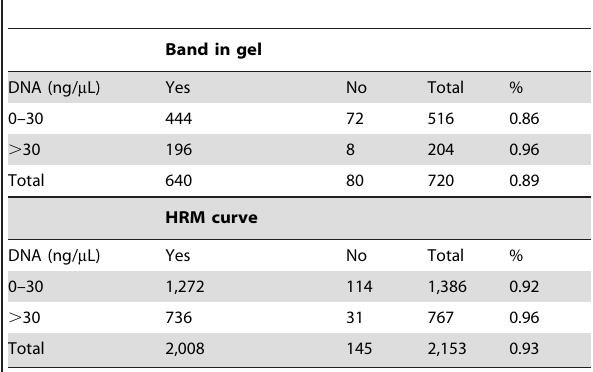
Table 5. Correlation between the quantity of DNA extracted from the paraffin-embedded tissue, used for pre-HRM PCR, and a band in the gel (p , 0.001). Also, correlation between DNA quantity and the presence of a HRM curve (p ,